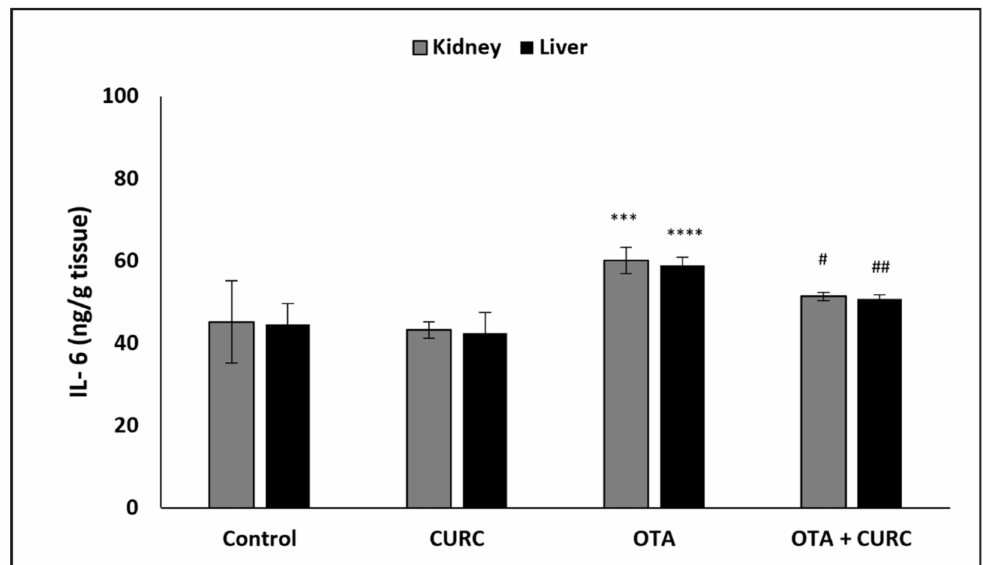
Figure 7. Effect of curcumin (CURC) on kidney and liver interleukin-6 (IL-6) level in different experimental groups after 14 days of treatment. Control group; CURC group (100 mg/kg b.w. of CURC); OTA group (0.5 mg/kg b.w. of OTA); OTA + CURC group (0.5 mg/kg b.w. of OTA plus 100 mg/kg b.w. of CURC). Data are expressed as mean ± standard deviation (SD) of n = 6 rats in each group. (*** p < 0.001 and **** p < 0.0001 vs. control; # p < 0.05 and ## p < 0.01 vs. OTA).